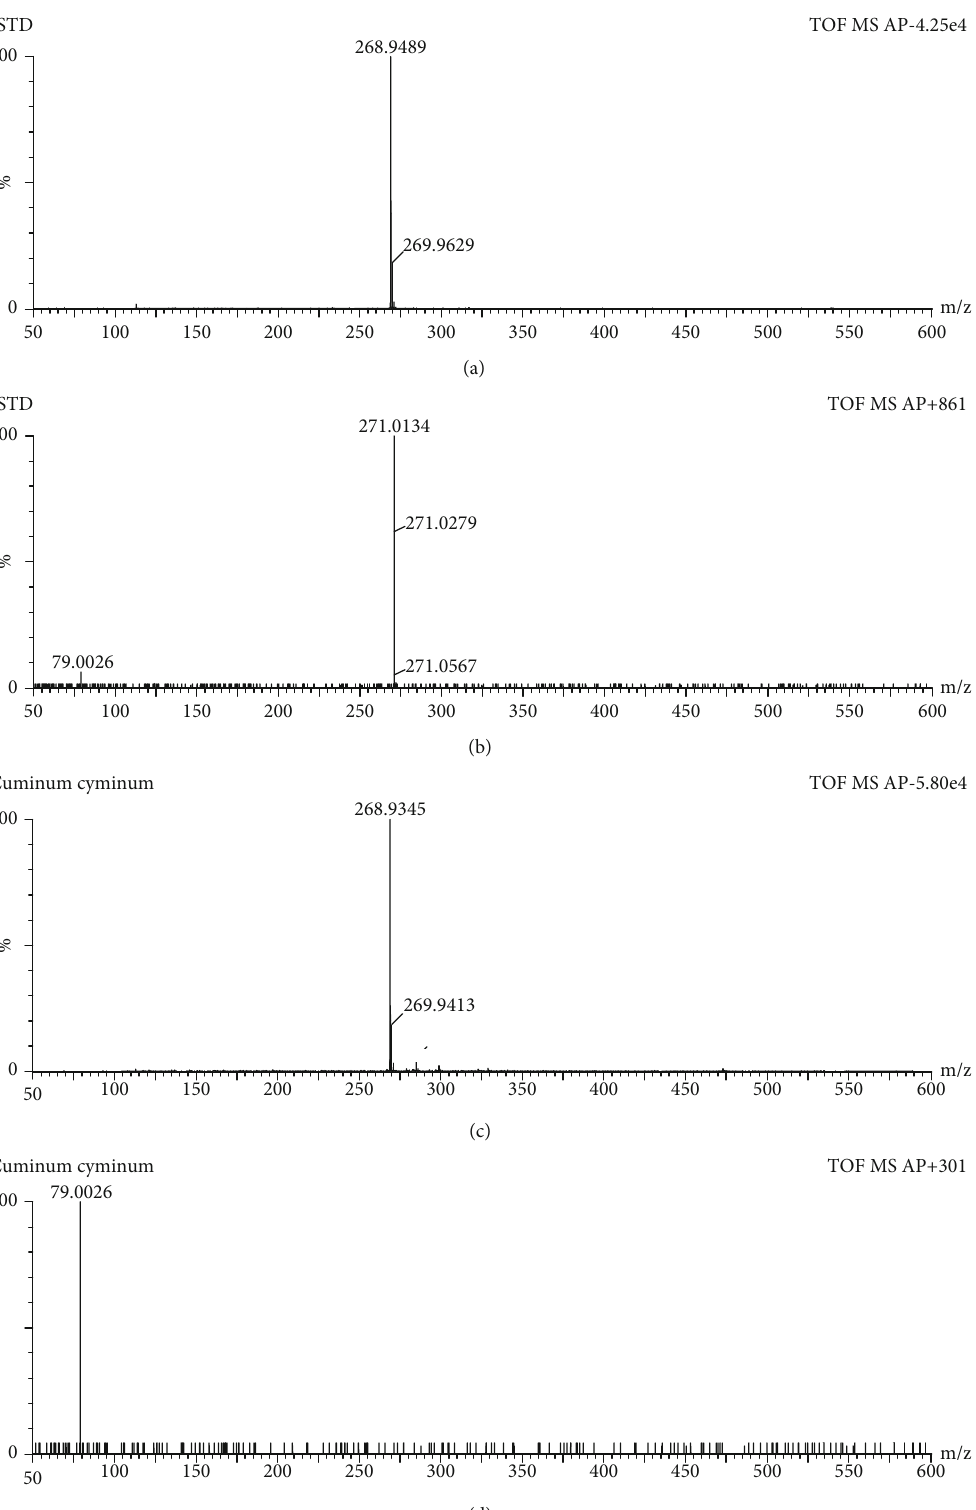
Figure 2: Mass spectrum of standard genistein and sample Cuminum cyminum ionized in negative mode (a, c) and in positive mode (b, d) by UPLC-APCI-TOF-MS,